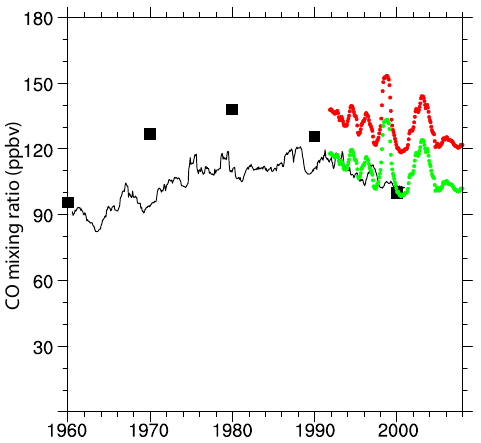
Fig. 7. Seasonal cycle of carbon monoxide (ppbv) at Mace Head for the 1990s. Observations (averaged 1991–1999) are in red, CAM- chem results are in black (solid line) and G-PUCCINI results are in black (solid squares).